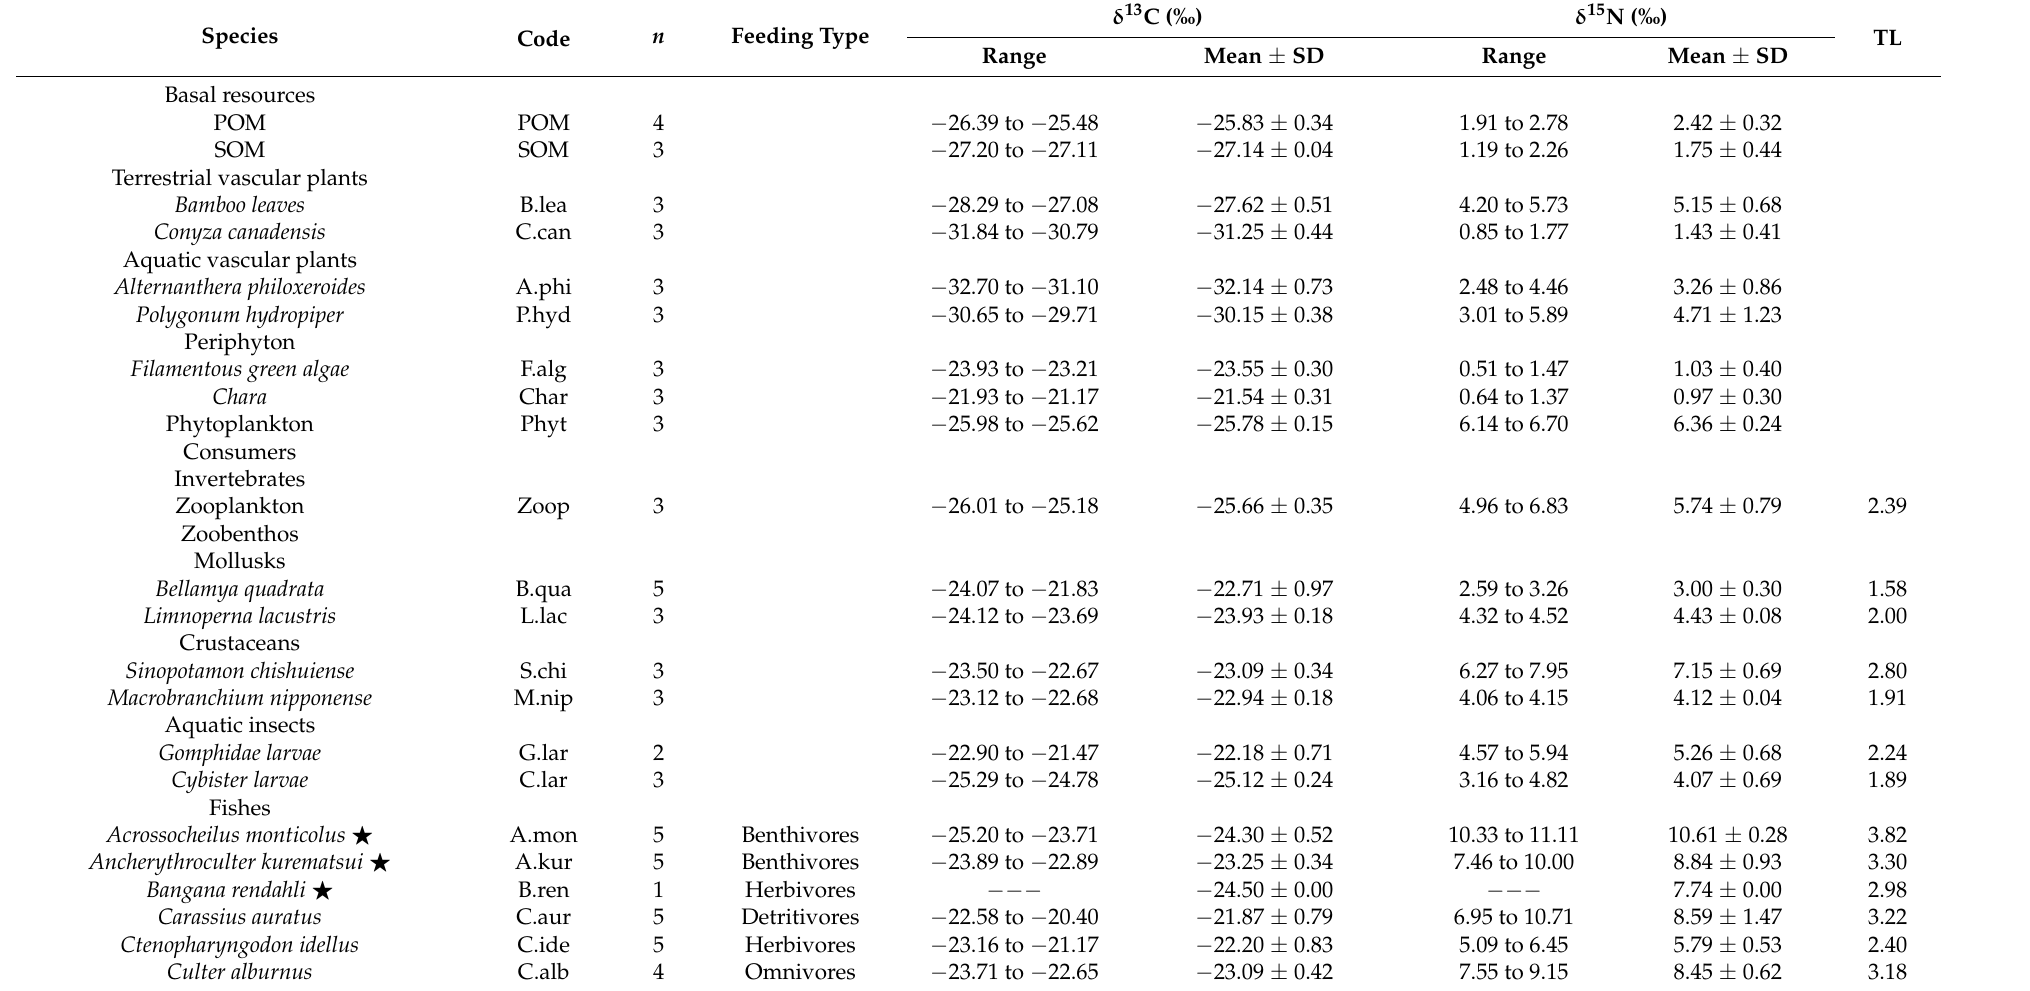
Table 1. Stable isotope ( δ 13 C and δ 15 N) signatures for basal resources and consumers in the midstream of the Chishui River.